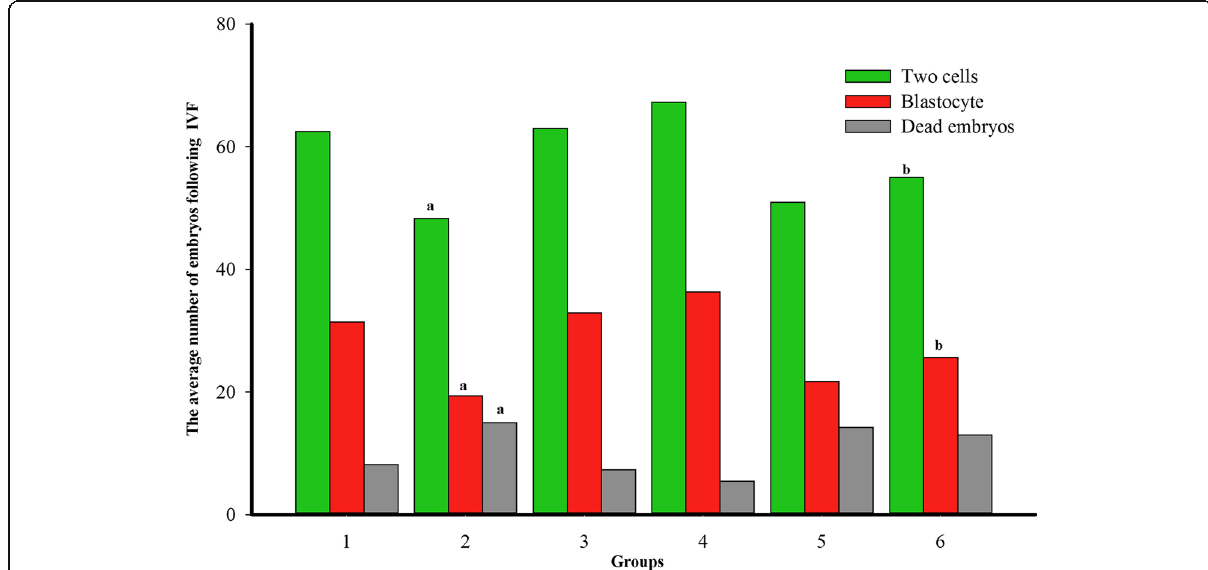
Fig. 3 Effect of silymarin and nicotine alone or in combination on the number of embryos and fertility in study groups. Data show the mean ± SD ( n = 10). a P < 0.001 as compared to normal control group. b P < 0.05 as compared to nicotine-treated